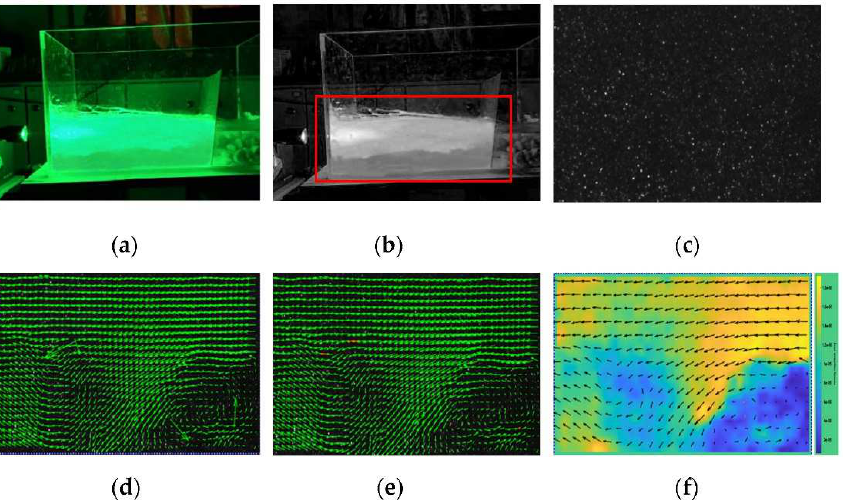
Figure 6. Test procedure: ( a ) physical picture; ( b ) grayscale processing; ( c ) processed images; ( d ) speed vector image; ( e ) vector calibration; ( f ) seepage velocity cloud.